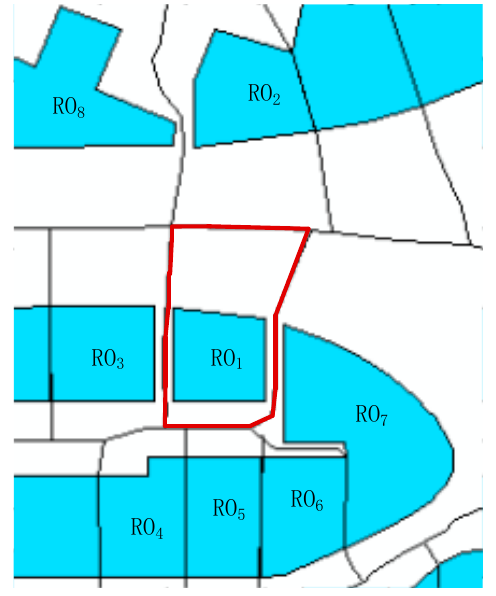
Figure 2. Voronoi region and neighbours of RO 1 .